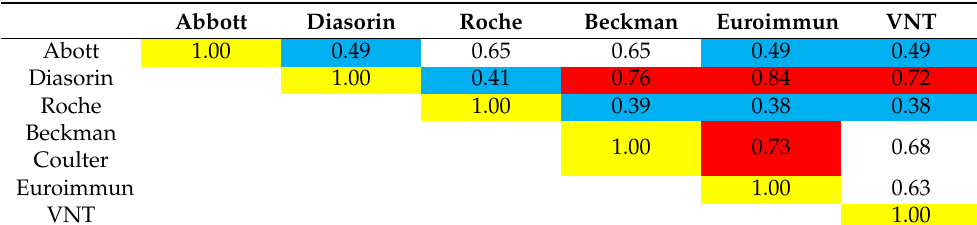
Table 4. Correlation of the individual immunoassays for the determination of SARS-CoV-2 antibodies and their correlation with the virus neutralization test